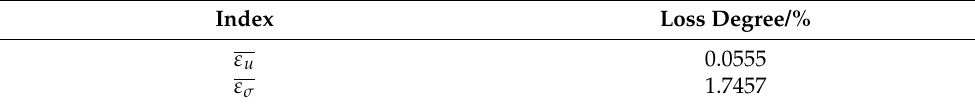
Table 7. Loss degree error comparison.